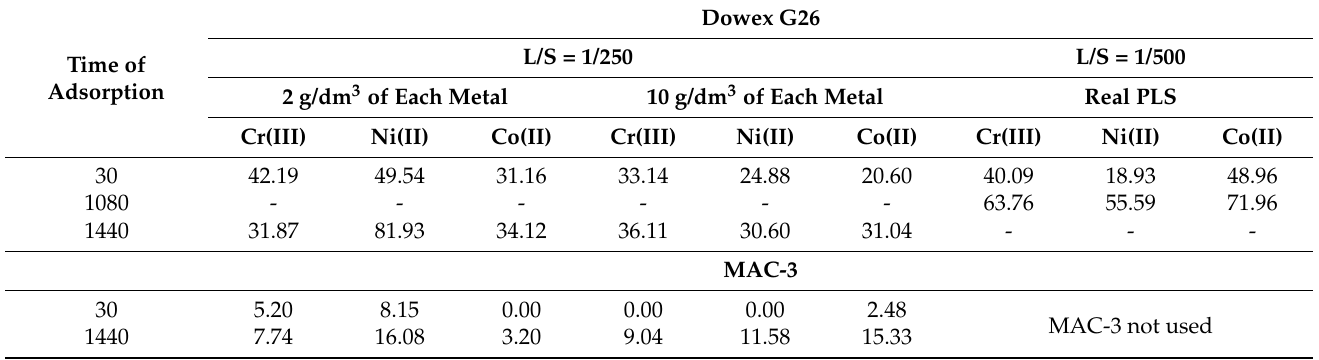
Table 7. Removal of Cr(III), Ni(II) and Co(II) from three-component model solutions and the real